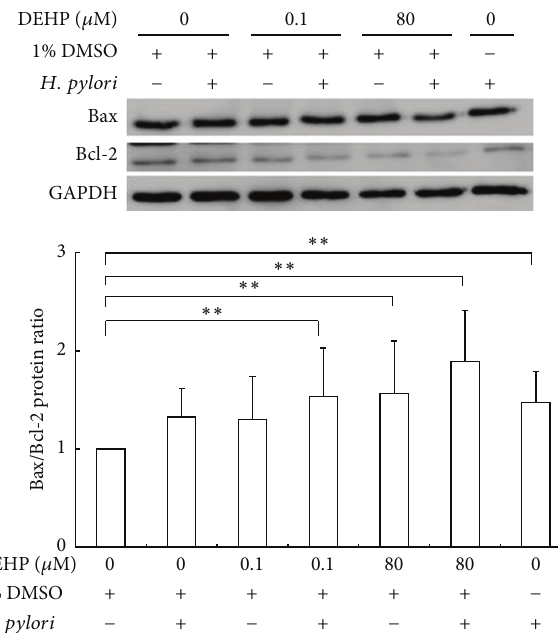
Figure 3: DEHP and H. pylori exposure for 3 hours changed the Bax/Bcl-2 ratio of AGS cells. Statistical significance was analyzed by one-way ANOVA and post hoc LSD test ( ∗∗ 𝑃 < 0.05 , 𝑁 = 4 ).